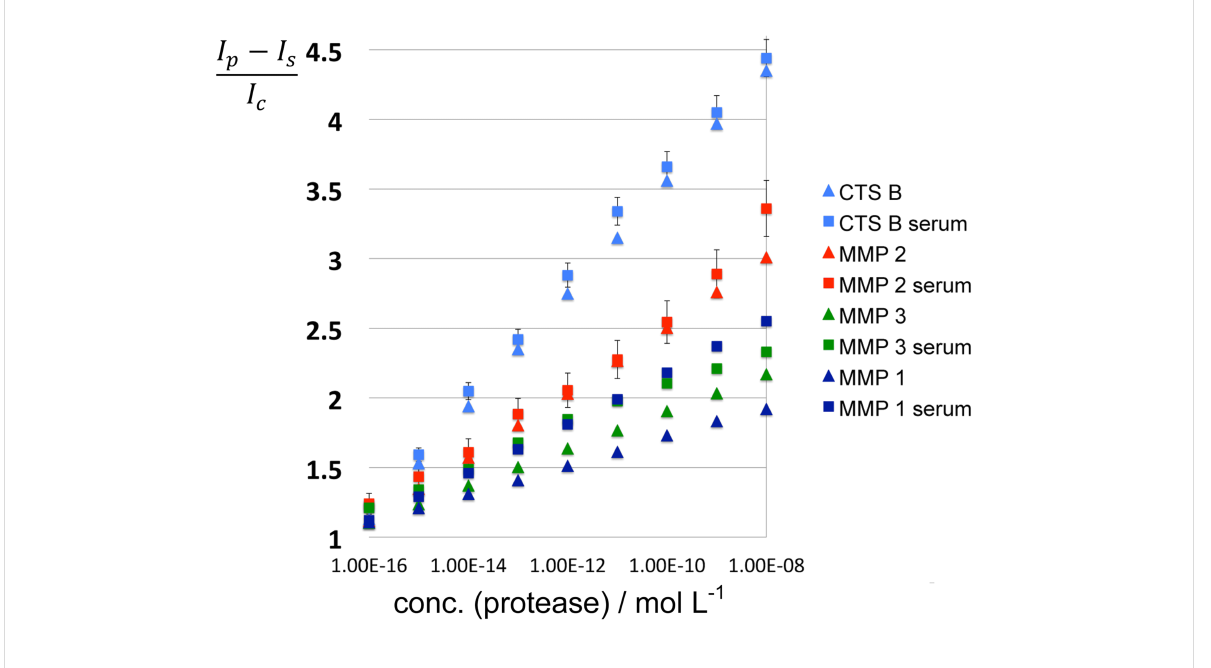
Figure 5: Matrix effects for MMP1, MMP 2, MMP 3, and cathepsin B after 60 min of incubation at 25 °C under standard conditions. Triangles: fluores- cence readings in PBS; Squares: fluorescence readings in PBS containing inactivated serum. I p : fluorescence signal after 60 min of incubation; I c : fluorescence signal in the absence of protease after 60 min incubation; I s : fluorescence signal of serum/PBS-dextran alone. Experimental errors are